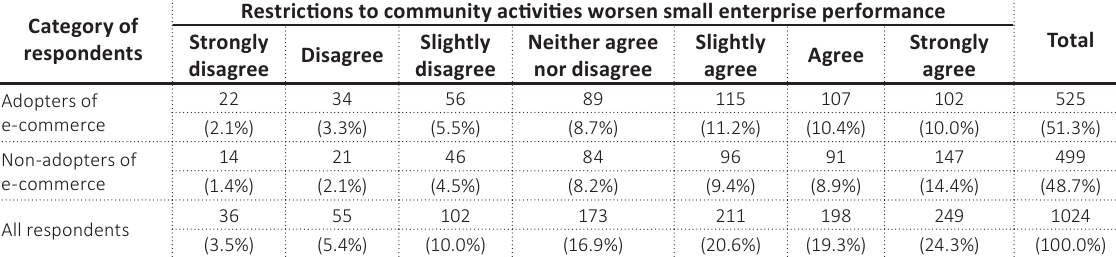
Table 4. Impact of restrictions to community activities (RCA)